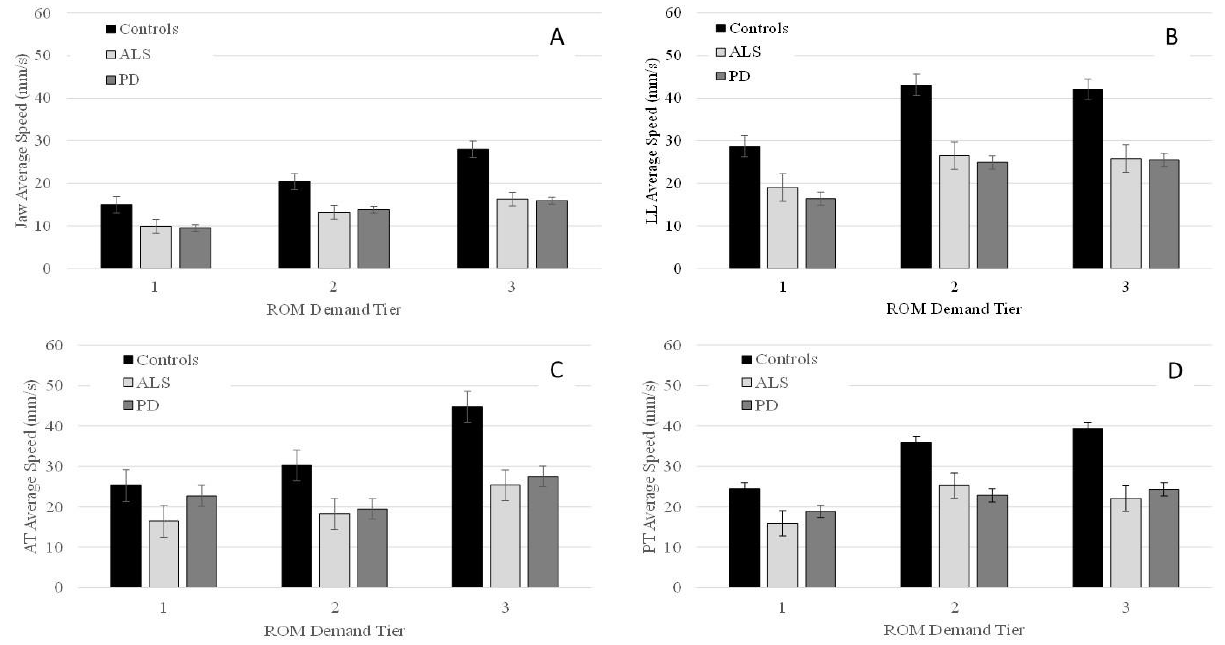
Figure 2. Group means (+/ − SE) for average speed of the jaw (Panel ( A )), lower lip (Panel ( B )), anterior tongue (Panel ( C )), and posterior tongue (Panel ( D )) across all ROM demand tiers.